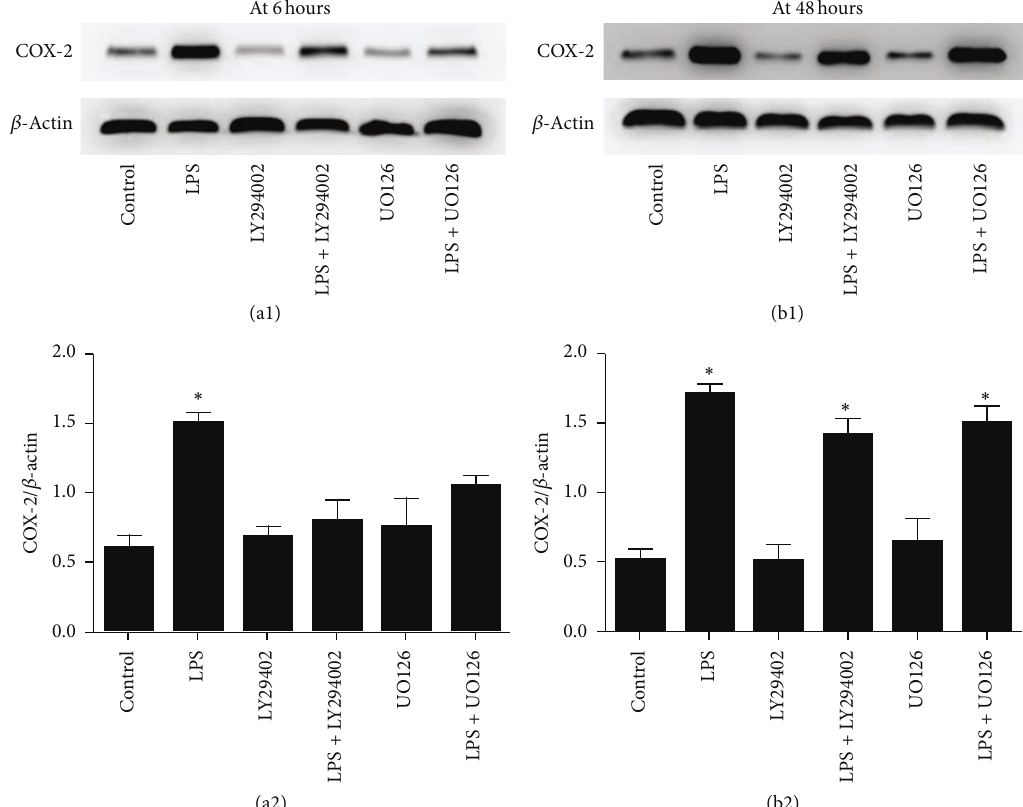
Figure 4: COX-2 protein expression is partly through the activation of ERK1/2 and PI3K/AKT signaling pathways in primary rat lung fibroblasts stimulated with LPS. ((a1), (a2)) COX-2 protein expression induced by LPS in primary rat lung fibroblasts at 6 hours (the first COX-2 expression peak) was suppressed by inhibitors of PI3K/AKT (LY294002) and ERK1/2 (UO126) ( ∗ 𝑃 < 0.05 versus control, LPS + LY294002, LPS + UO126, LY294002, and UO126 groups). There is no significant change between control, LY294002, and UO126 groups ( 𝑃 > 0.05 ). ((b1), (b2)) COX-2 protein expression induced by LPS in primary rat lung fibroblasts at 48 hours (the second COX-2 expression peak) was not suppressed by inhibitors of PI3K/AKT (LY294002) and ERK1/2 (UO126) ( ∗ 𝑃 < 0.05 versus control, LY294002, and UO126 groups). There is no significant change between LPS, LPS + LY294002 and LPS + UO126 groups ( 𝑃 > 0.05 ). All experiments were repeated in